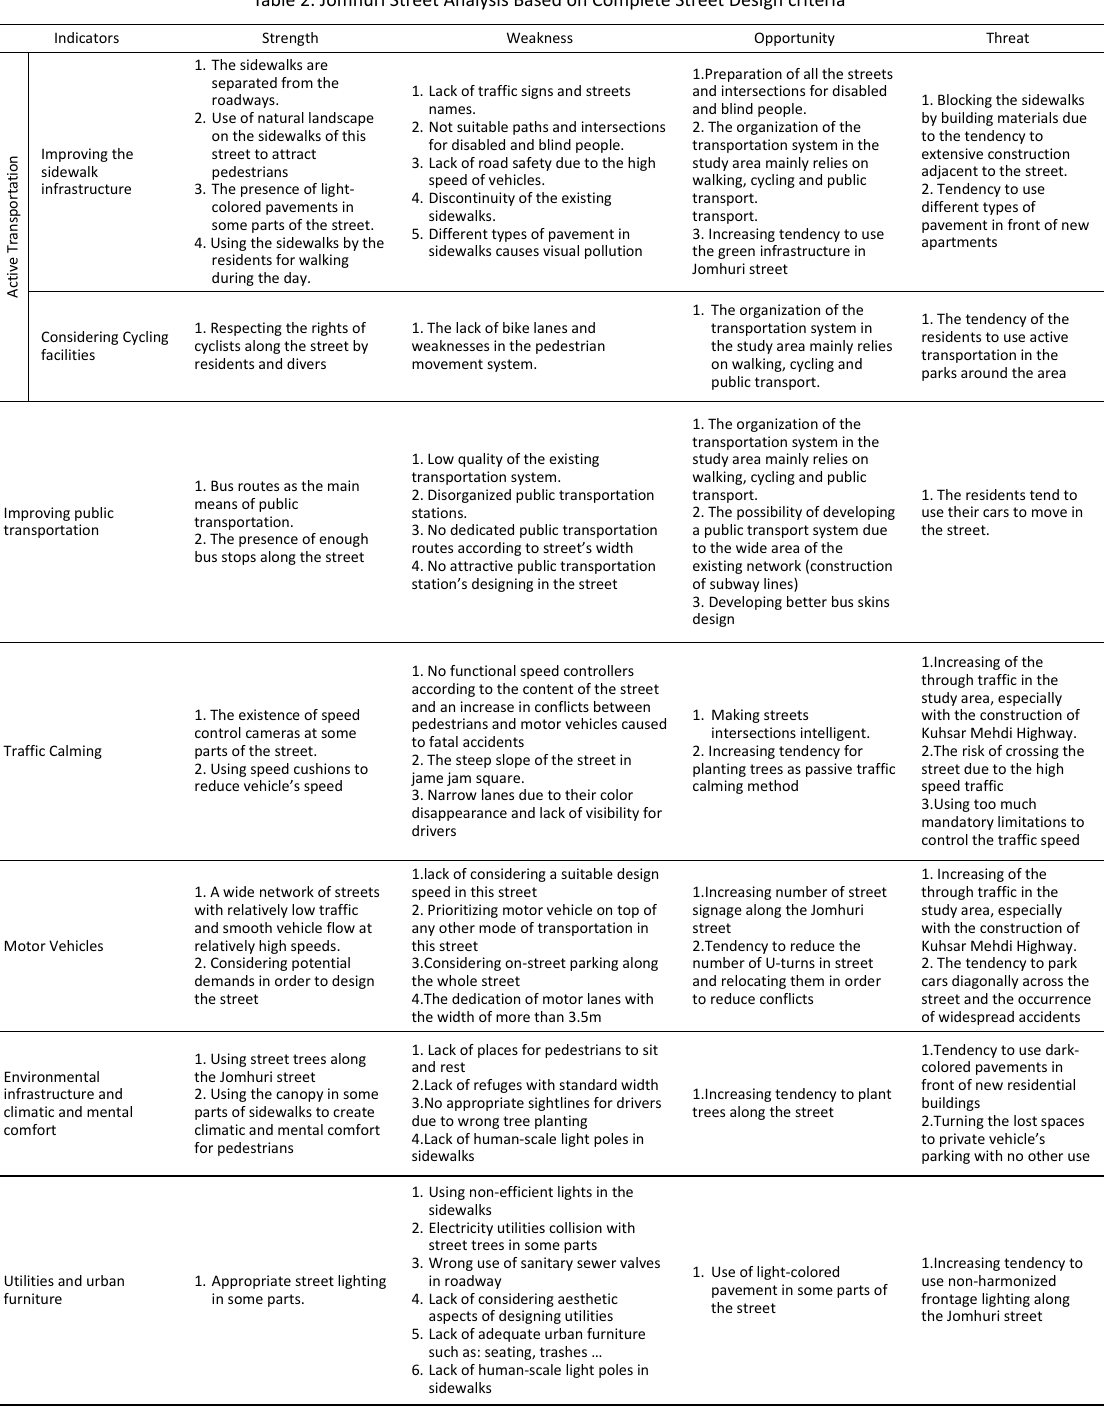
Table 2: Jomhuri Street Analysis Based on Complete Street Design criteria Table 2. Jomhuri Street Analysis Based on Complete Street Design